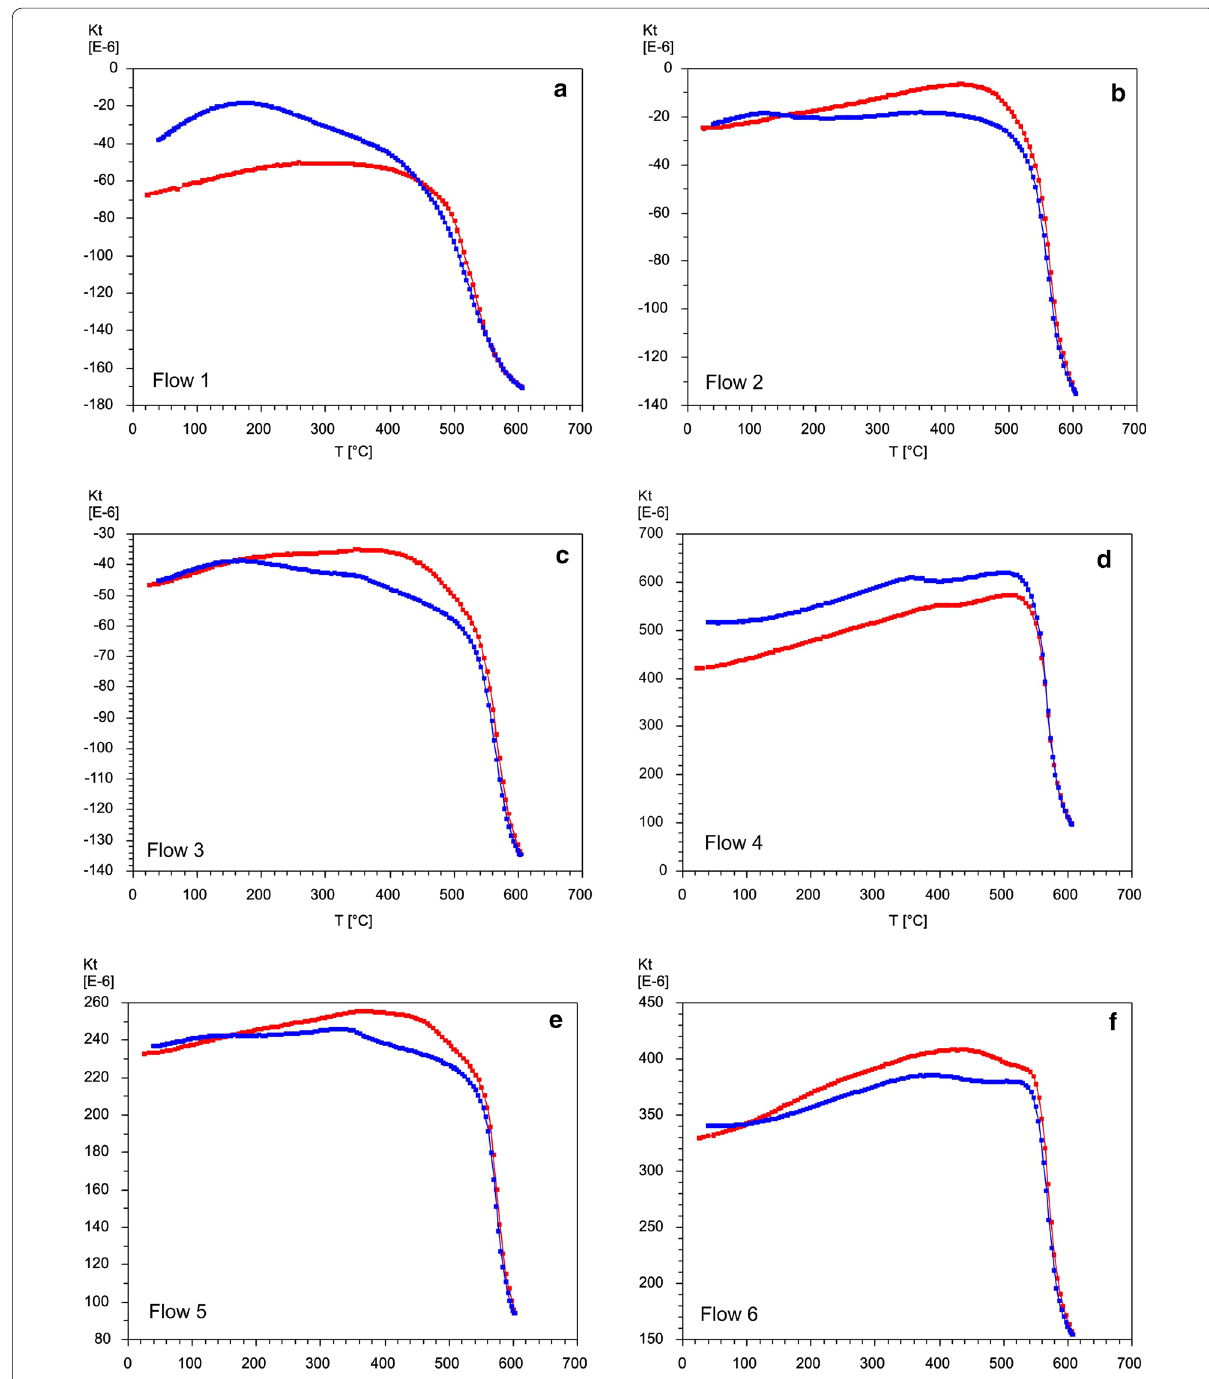
Fig. 3 Representative thermomagnetic (κ‑T) curves for the different flows analyzed, obtained in the previous study (Cervantes‑Solano et al. 2019). Curves in red correspond to the heating, while those in blue to the